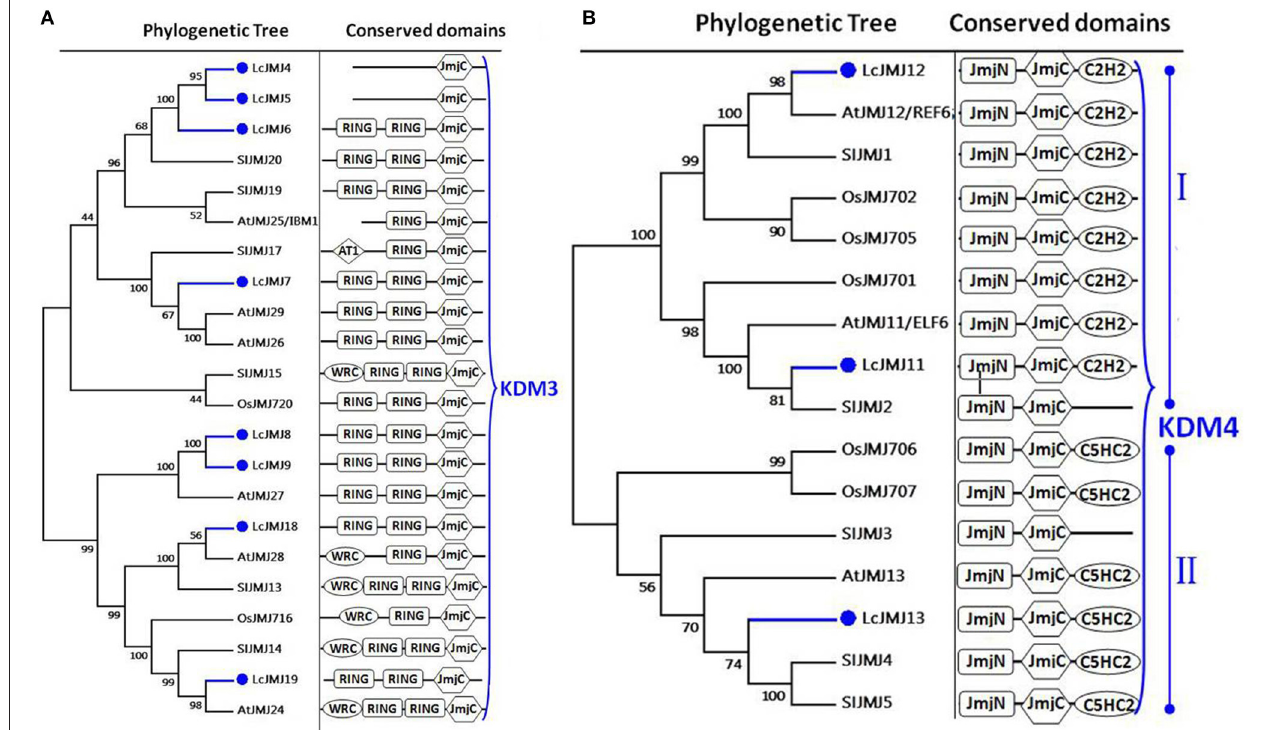
FIGURE 6 | Maximum likelihood phylogenetic trees and schematic diagrams for domain composition of KDM3 class and KDM4 class HDM proteins predicted from Litchi chinensis (Lc), Arabidopsis thaliana (At), Oryza sativa (Os) and Solanum lycopersicon (Sl). (A) Phylogenetic tree and schematic diagrams for domain composition of KDM3 class HDM proteins. RING-finger (IPR001841) and JmjC (PF02373) are conserved domains of KDM3 class. (B) Phylogenetic tree and schematic diagrams for domain composition of KDM4 class proteins which are further divided into two groups. N-terminal JmjN (PF02375) and JmjC, and C-terminal C5HC2 (PF02928) (subgroup I) or C2H2 (PF00096) (subgroup II) domains are conserved domains of KDM4 proteins. The phylogenetic tree was constructed based on the amino acids sequences with 1,000 bootstrapping replicates.